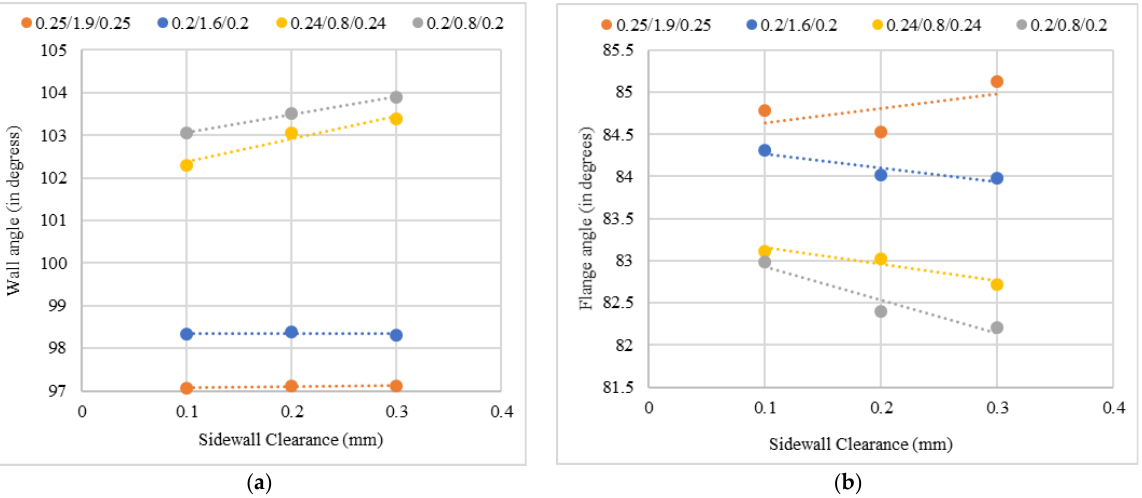
Figure 20. ( a ) Effect of sidewall clearance on wall angle and ( b ) flange angle for different thickness combinations of the sandwich laminates.